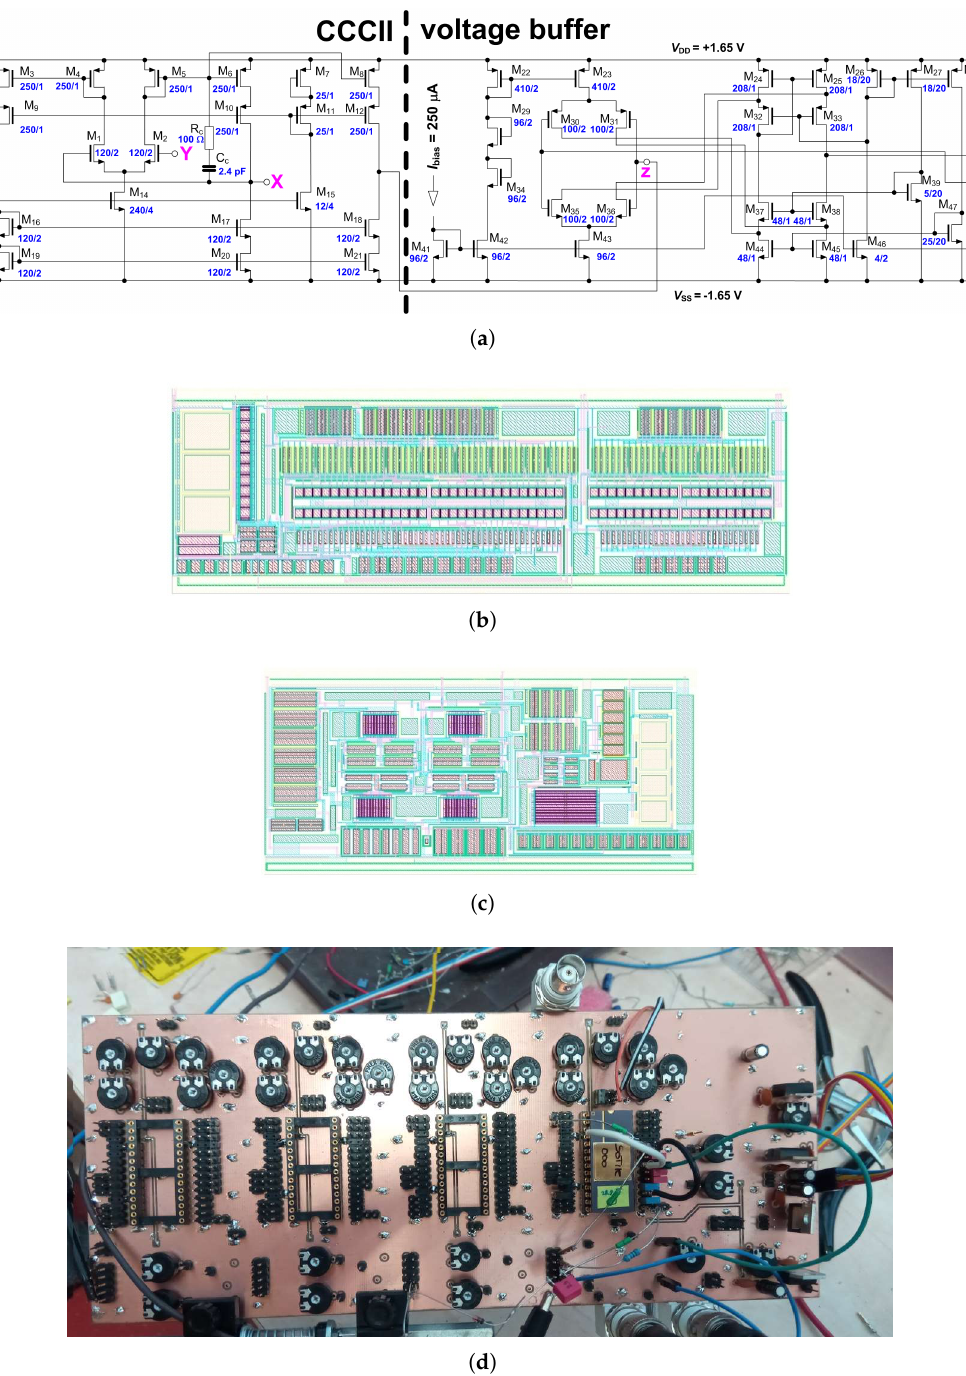
Figure 5. ( a ) The complete CMOS topology of CFOA; layouts of CFOA cells (on a single IC package) fabricated in I3T25 process: ( b ) current controlled current conveyor of second generation (CCCII) and ( c ) voltage buffer; and ( d ) the realized and measured prototype of readout (CFOA and f 0 → V sens